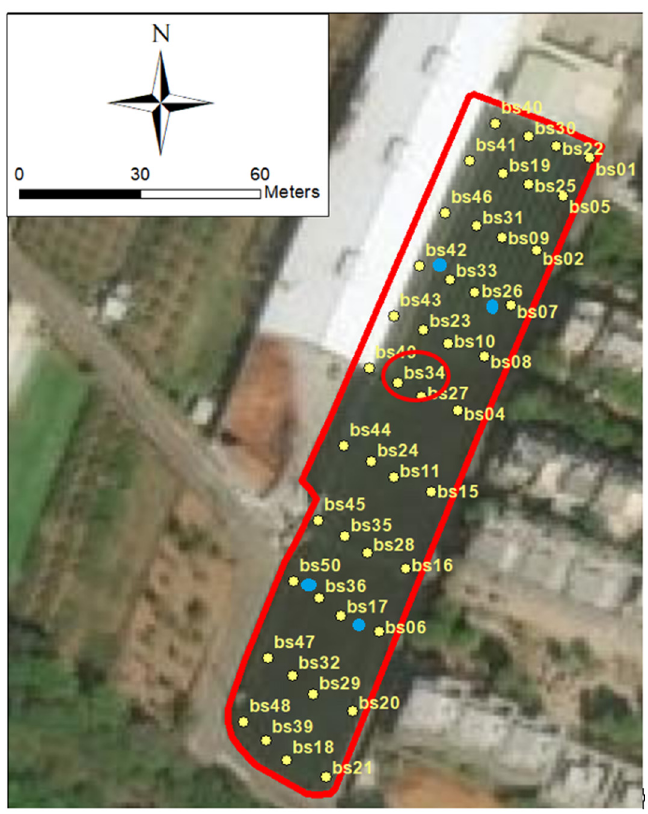
Figure 3. Distribution of sensors and gateways in the Oncidium greenhouse.